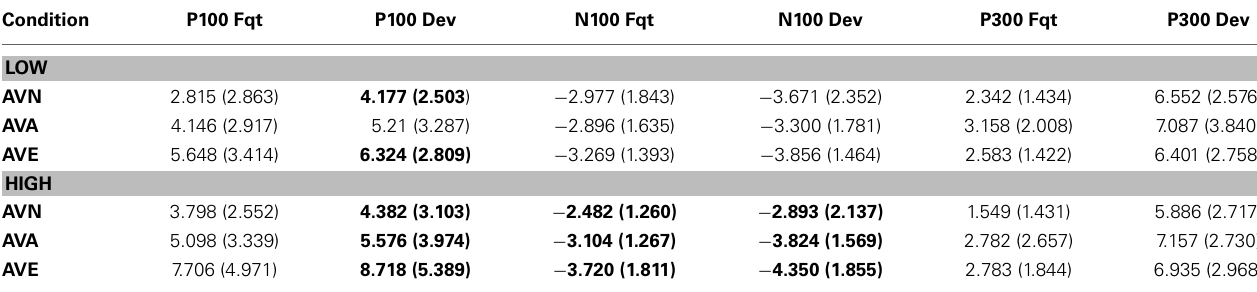
Table 6 | Means and standard deviations (in parentheses) of P100, N100 and P300 amplitudes for frequent and deviant stimuli, in the “emotional” bimodal-AVE, “animal” bimodal-AVA and “neutral” bimodal task-AVN, for each group. Condition